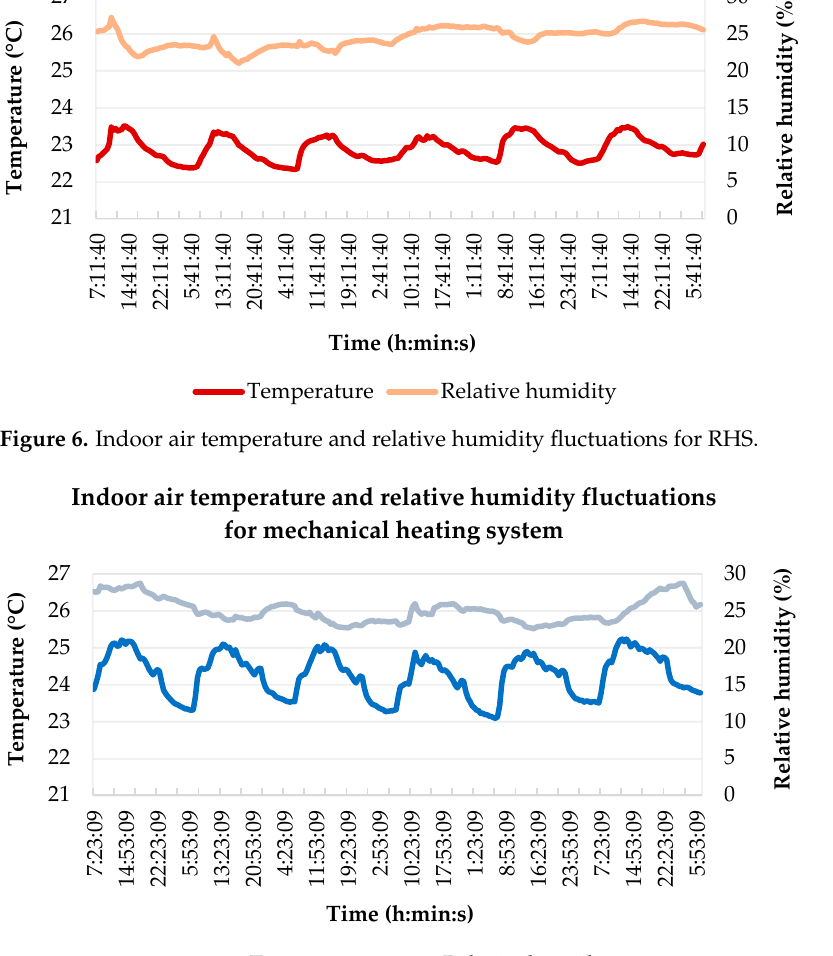
Figure 9. Outdoor air temperature and relative humidity fluctuations for MHS [32]. The results of the surface temperatures measurements are summarized in Table 5. The total average temperature of all monitored surfaces for the radiant ceiling heating system was determined to be 23.15 °C, with the highest average temperature of 23.65 °C being measured on the floor and the lowest of 22.51 °C being recorded on the external wall surface. In contrast, with fan coil heating, the highest average surface temperature of 24.55 °C was measured on the ceiling surface. Although the lowest average surface temperature was measured on the same surface as in the ceiling radiant heating, in the case of the fan coil it was higher by 0.75 °C. The total average temperature of all surfaces reached 24.22 °C. The values of the operative temperature in the case of both systems corresponded to the optimal (20–24 °C) and permissible (18–26 °C) legislative ranges. However, with a mechanical heating system, the operative temperature value was slightly higher compared to with a radiant heating system.